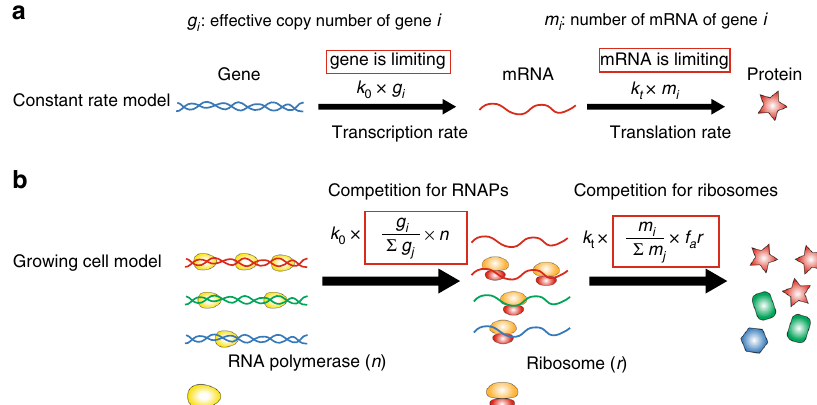
Fig. 1 The growing cell model of stochastic gene expression in comparison with constant rate models. a In the constant rate model, the transcription rate is proportional to the gene copy number, and the translation rate is proportional to the mRNA number. These assumptions imply that the gene number and mRNA number are the limiting factors in gene expression. b In Phase 1 of the growing cell model, we introduce as limiting factors RNA polymerases (RNAPs) and ribosomes. Genes with different colors are transcribed with different rates. Here k 0 is a constant and the gene regulation is coarse-grained P ¼ g = into the gene allocation fraction ϕ g j . g i is the effective copy number of gene i (also accounting for the promoter strength). n is the total number of i i j RNAPs. Translation rates of mRNA depend on the number of active ribosomes ( f a r ), the translation rate k t , and the fraction of mRNA i in the total pool of mRNA. In a later section (A uni fi ed phase diagram of gene expression and cellular growth), we will relax our assumptions and consider situations in which the limiting factors of gene expression become the gene number and the mRNA